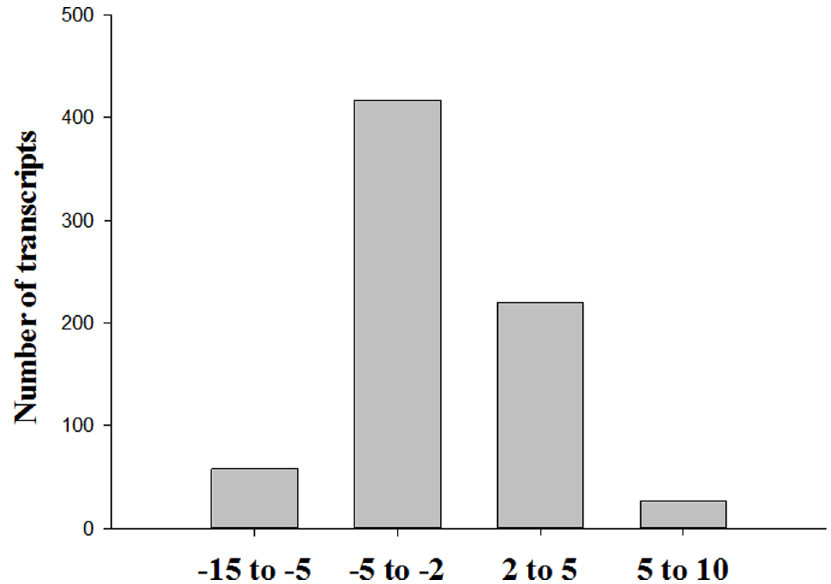
Figure 3. Number and Fold change distribution of differentially expressed genes between the SG/RG libraries. doi:10.1371/journal.pone.0112722.g003 PLOS ONE |